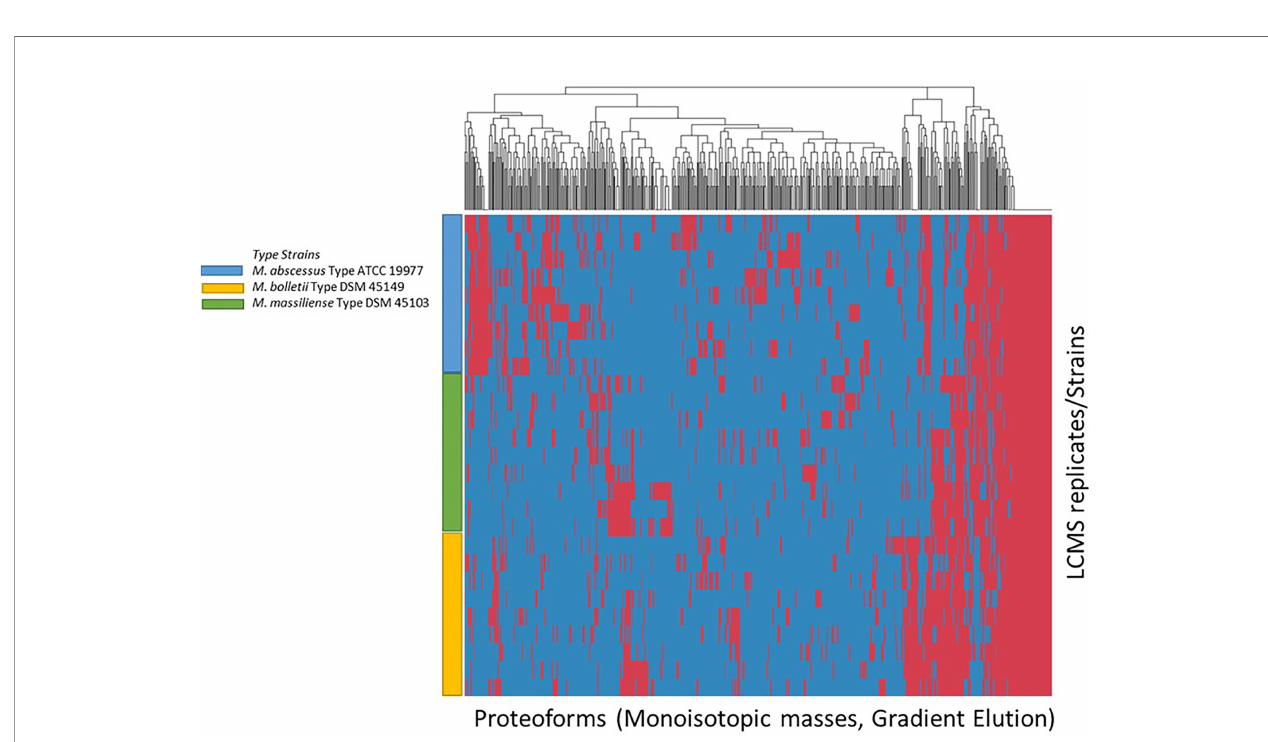
FIGURE 5 | Clustering of Proteoforms visualized as heat map for M. abscessus , M. massiliense and M. bolletii using gradient elution with top 500 proteoforms